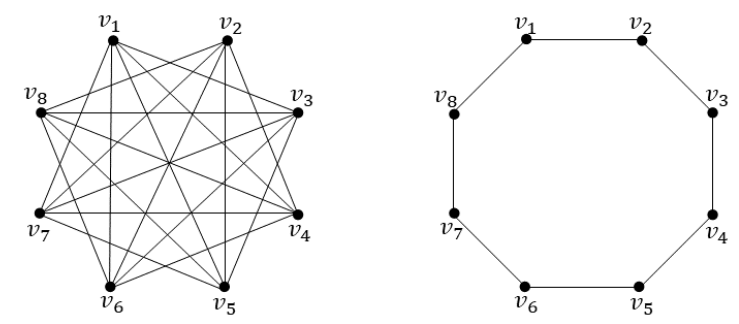
Figure 6. The graph K 8 − C 8 and its δ -complement C 8 .